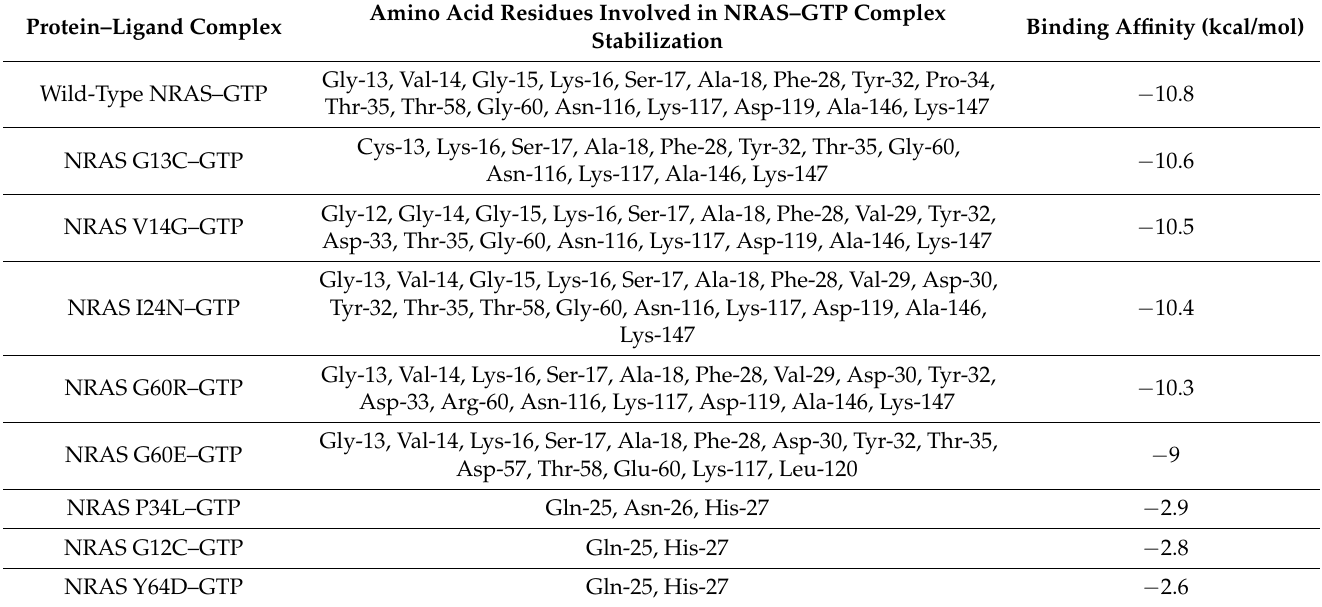
Table 3. Binding affinity between NRAS proteins and